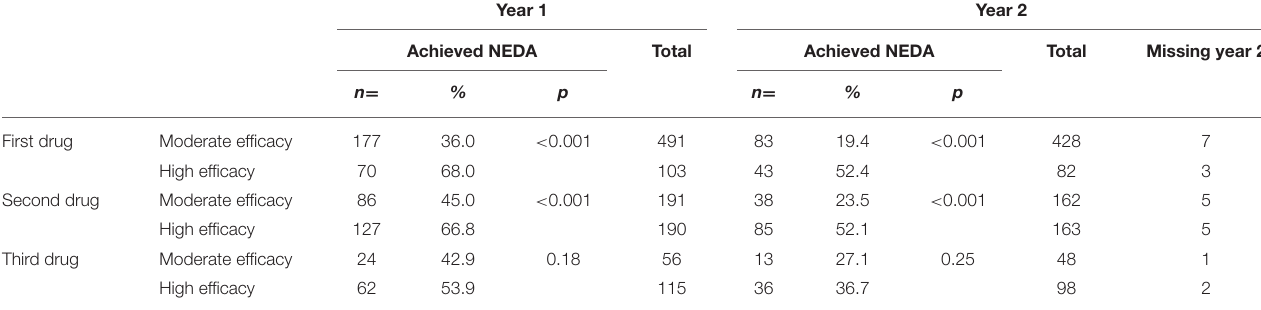
TABLE 4 | NEDA year 1 and NEDA year